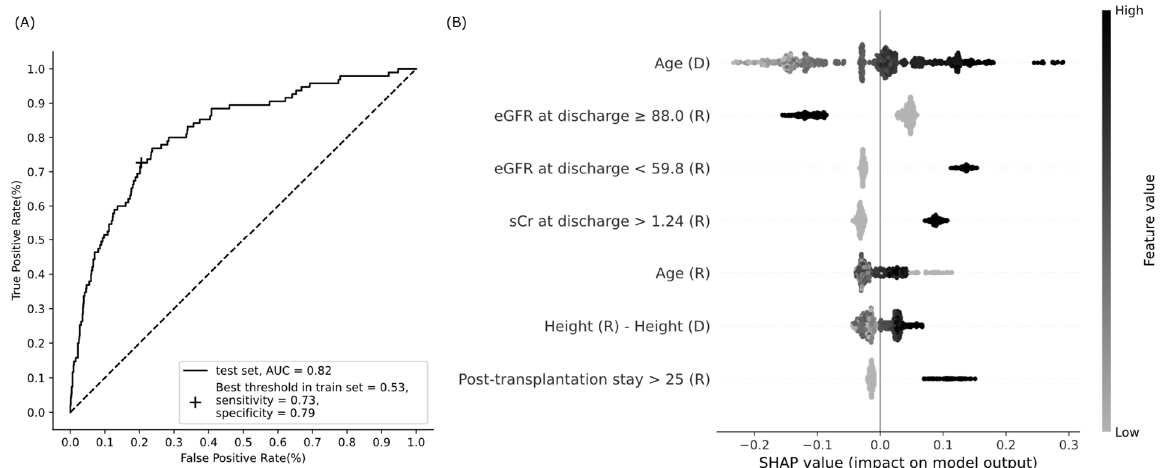
Figure 2. Performance of the XGBoost model to predict a decline in eGFR at one year after kidney transplantation. ( A ) Receiver operating characteristic curve; ( B ) summary plot of Shapley additive explanations (SHAP). Model features are sorted along the y axis of the summary plot by the sum of SHAP value (probability) magnitudes over all cases in the test data, and the distribution of each feature’s impacts is plotted using SHAP values of individual cases. Binary features have 1 if present, or 0 if absent. Abbreviations: AUC, area under the curve; eGFR, estimated glomerular filtration rate (mL/min/1.73 m 2 ); sCr, serum creatinine (mg/dL); D, donor; R,